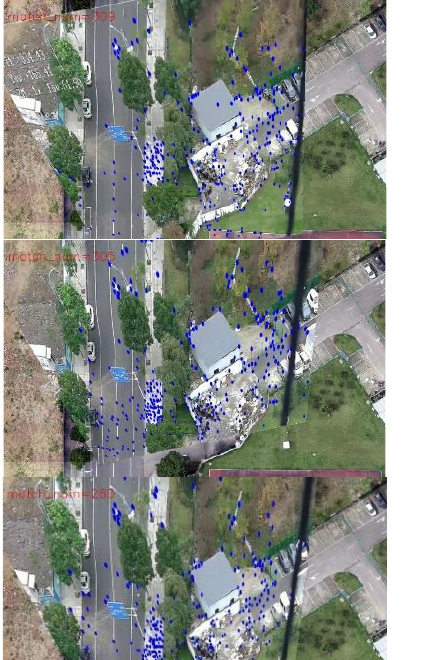
Figure 23. Registration difference image (after updating the map features).